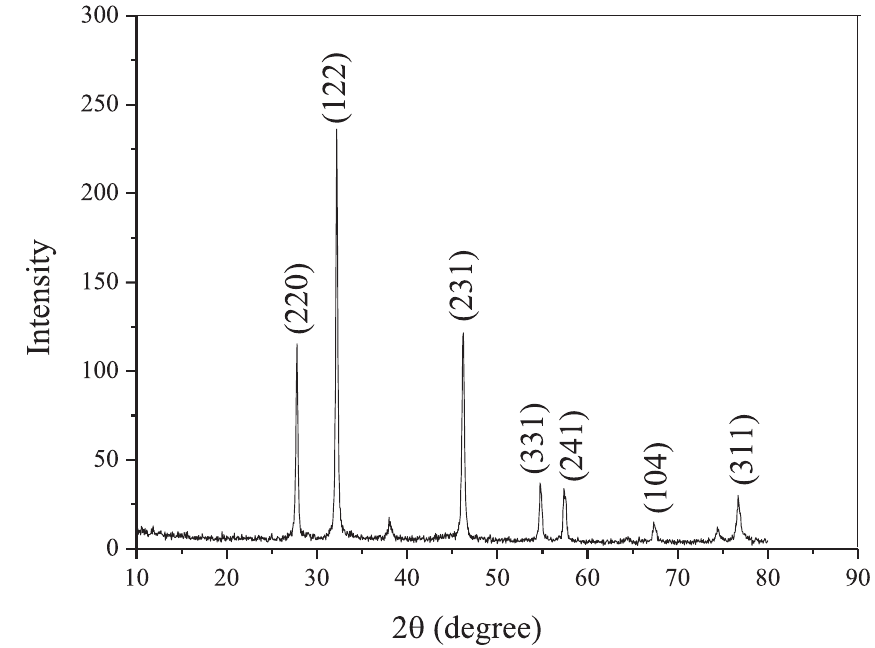
Figure 4: XRD pattern of silver